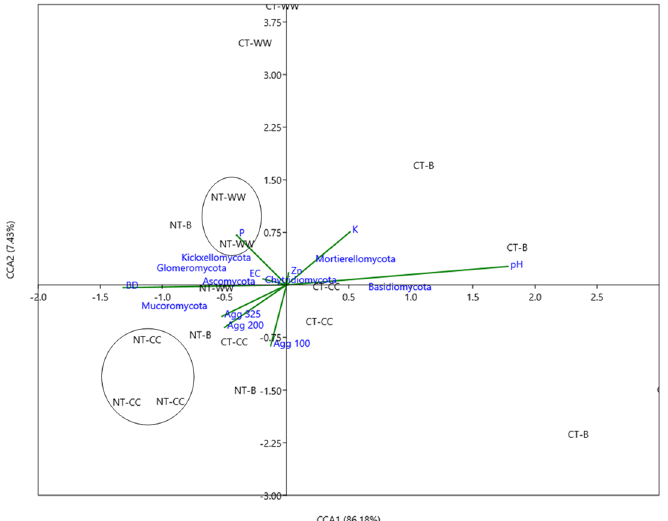
Figure 4. The distance based canonical correspondence analysis (CCA) showing the distribution of soil fungal communities (performed using fungal relative abundances) and soil characteristics in the different tillage and cover management systems. Soil properties and fungal phyla are labelled in blue and treatments are in black color. CT-B: Conventional Tillage-Bare fallow; CT-CC: Conventional Tillage-Cover Crop; CT-WW: Conventional Tillage-Winter weeds; NT-B: No-tillage- Bare fallow; NT-CC: No-tillage-Cover Crop; NT-WW: No-tillage-Winter Weeds.